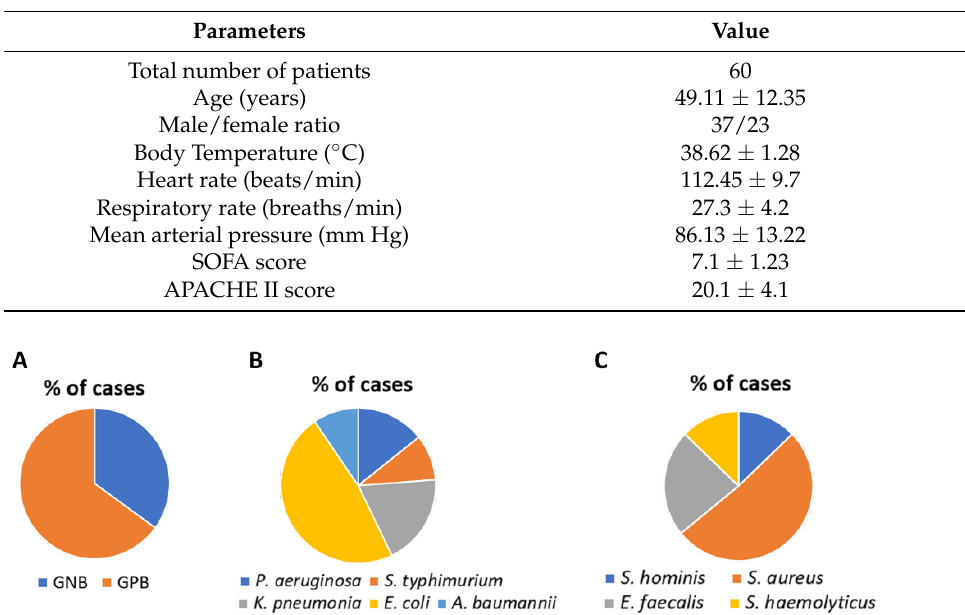
Table 1. Patient demographic features (mean ± standard deviation).